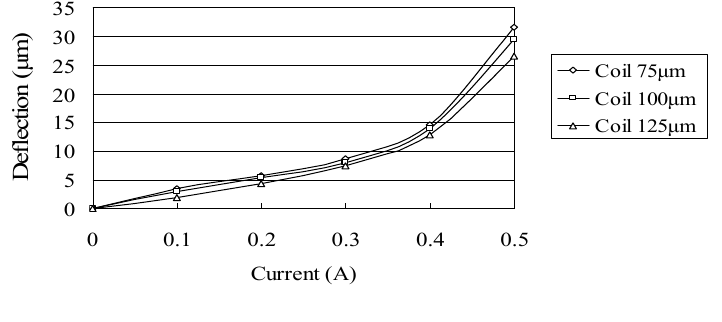
Figure 6. Variation of maximum diaphragm deflection with input current as function of coil width without driving liquid.